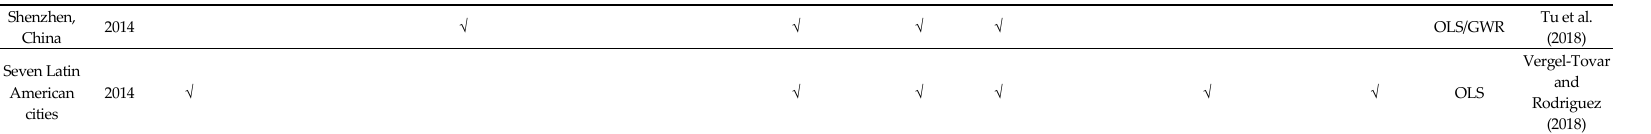
Table 1. Cont. Appl. Sci. 2019 , 9 , x FOR PEER